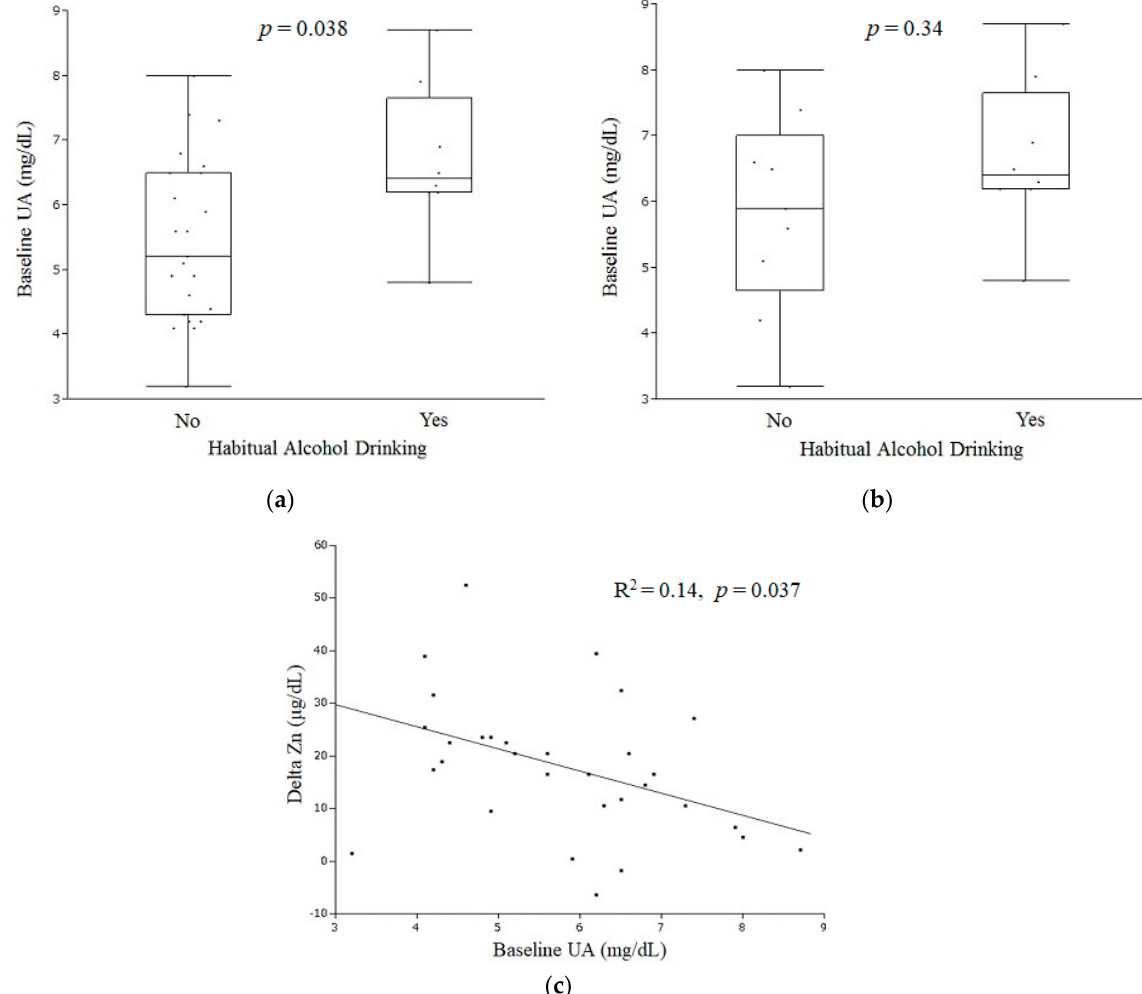
Figure 3. Relationship between Baseline UA and Other Parameters. ( a ) In the baseline Zn < 65 µg/dL (31/95, 32.6%) subgroup, patients having habitual alcohol drinking (8/31, 25.8%), showed significantly higher baseline UA levels (mean UA, 6.69 vs. 5.46, p = 0.038, Wilcoxon test). ( b ) Baseline UA levels in male patients with habitual alcohol drinking (8/17, 47.1%) showed the same tendency of higher baseline UA as in part ( a ). However, no significant difference was found. ( c ) In the baseline Zn < 65 µg/dL (31/95, 32.6%) subgroup, baseline UA levels were negatively correlated with delta Zn ( R 2 = 0.14, p = 0.037, linear regression analysis). UA, uric acid.